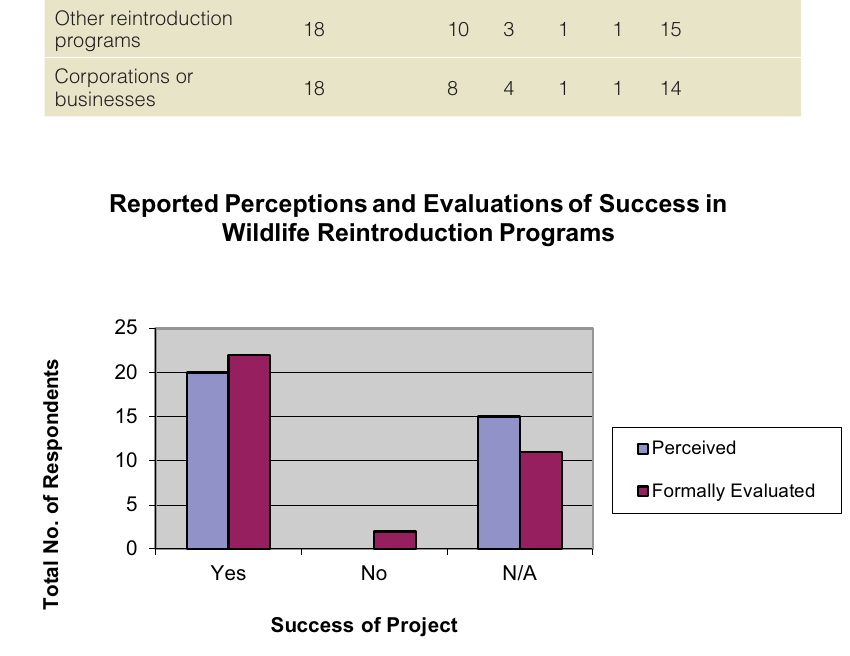
Figure 12. Self-assessed and evaluated success in wildlife reintroduction